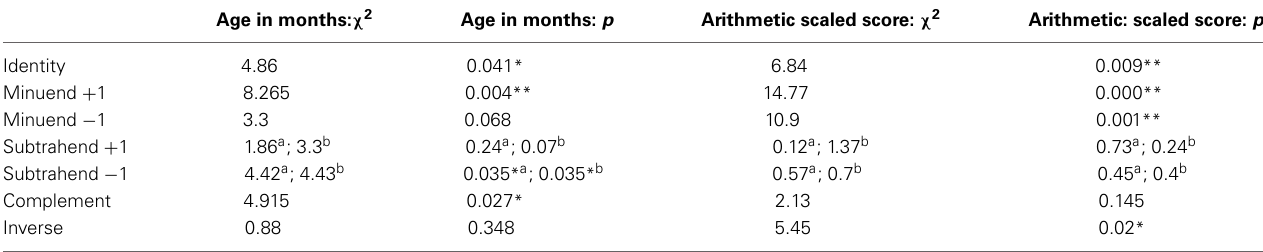
Table 4 | Results of nominal logistic regression on use of subtraction strategies with age and arithmetic scaled score as covariates. Age in months: χ 2 Age in months: p Arithmetic scaled score: χ